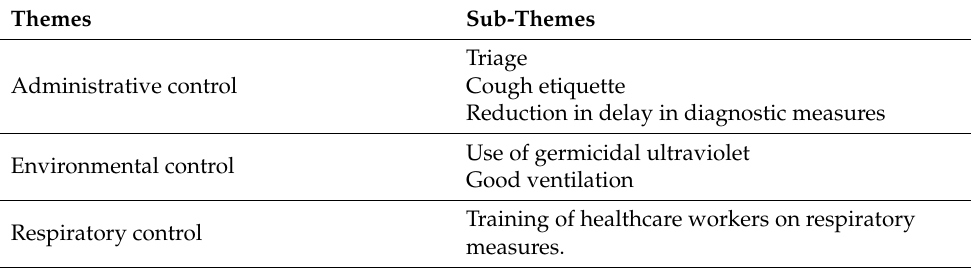
Table 2. Summary of findings from data